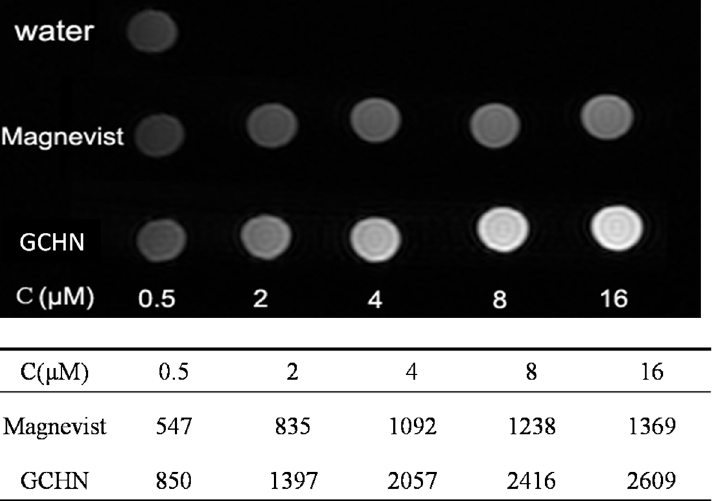
Figure 6. MRI images and the signal intensity in vitro of Magnevist and